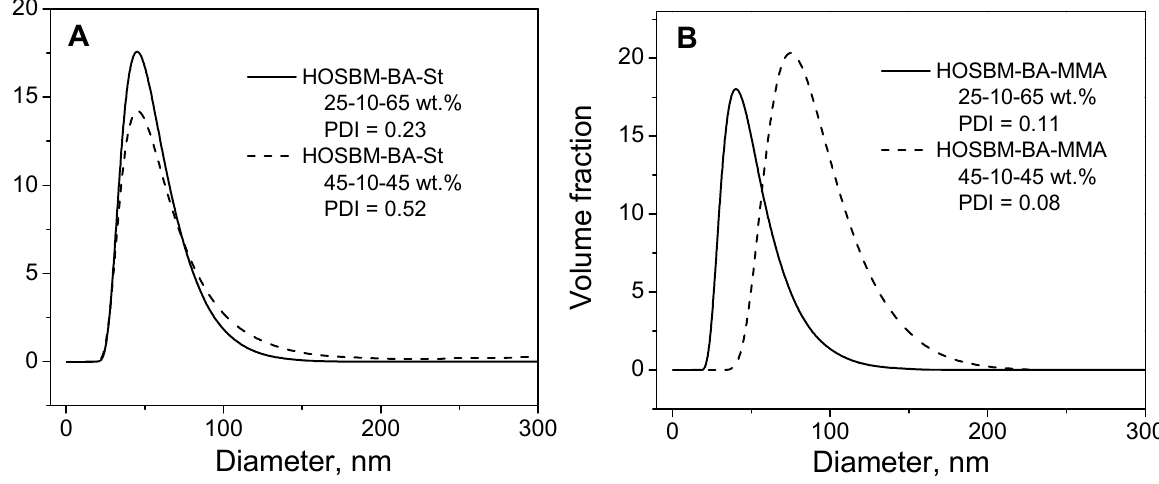
Figure 3. Latex particle size distribution of the biobased terpolymers HOSBM-BA-St ( A ) and HOSBM-BA-MMA ( B ).